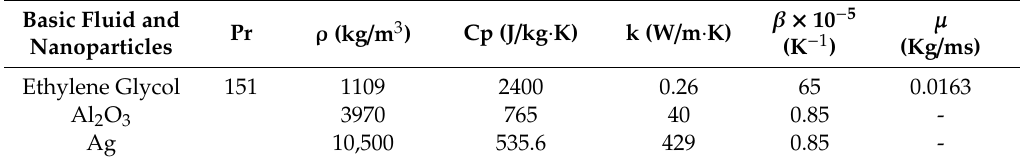
Table 2. Thethermophysicalpropertiesofthebasefluid(ethyleneglycol)withAgandAl 2 O 3 nanoparticles. Basic Fluid